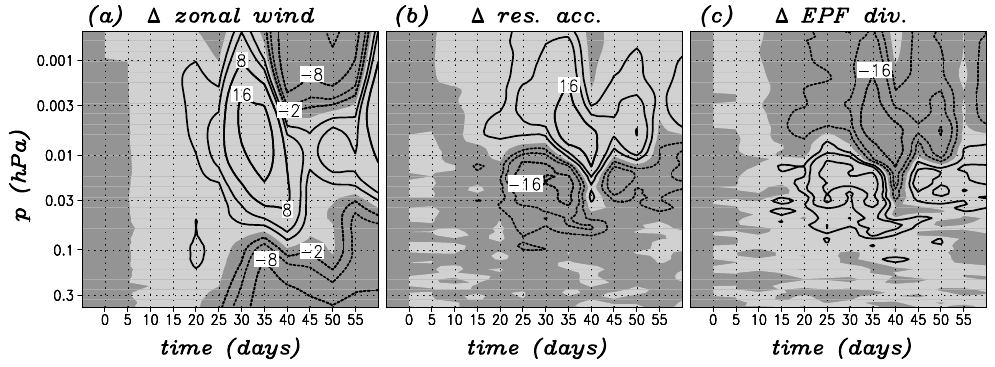
Figure 10: Transient model response with respect to (a) zonal-mean zonal wind (contours Fig. 10. Transient model response with respect to (a) zonal-mean zonal wind (contours ± 2 , 4 , 8 , 16ms − 1 ), (b) residual acceleration (contours ± 4 , 8 , 16ms − 1 d − 1 ), and (c) EPF divergence (contours ± 4 , 8 , 16ms − 1 d − 1 ). Each quantity is averaged over 5 days and from 15 ◦ N to 60 ◦ N. Positive and negative values are indicated by light and dark 2 , 4 , 8 , 16 ms − 1 ), (b) residual acceleration (contours 4 , 8 , 16 ms − 1 d − 1 ), and (c) EPF ± ± divergence (contours 4 , 8 , 16 ms − 1 d − 1 ). Each quantity is averaged over 5 days and from ± 15 o N to 60 o N. Positive and negative values are indicated by light and dark shading.